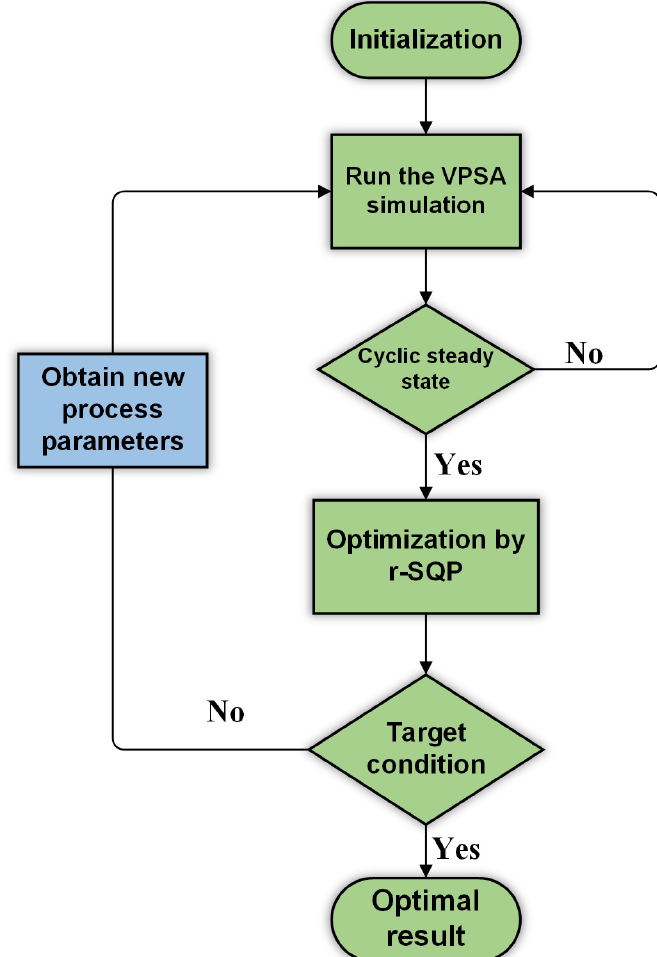
Figure 3. A generic optimization framework from Ding et al. [67]. Readapted with permission from Ref. [67]. Copyright 2018 Springer Nature.